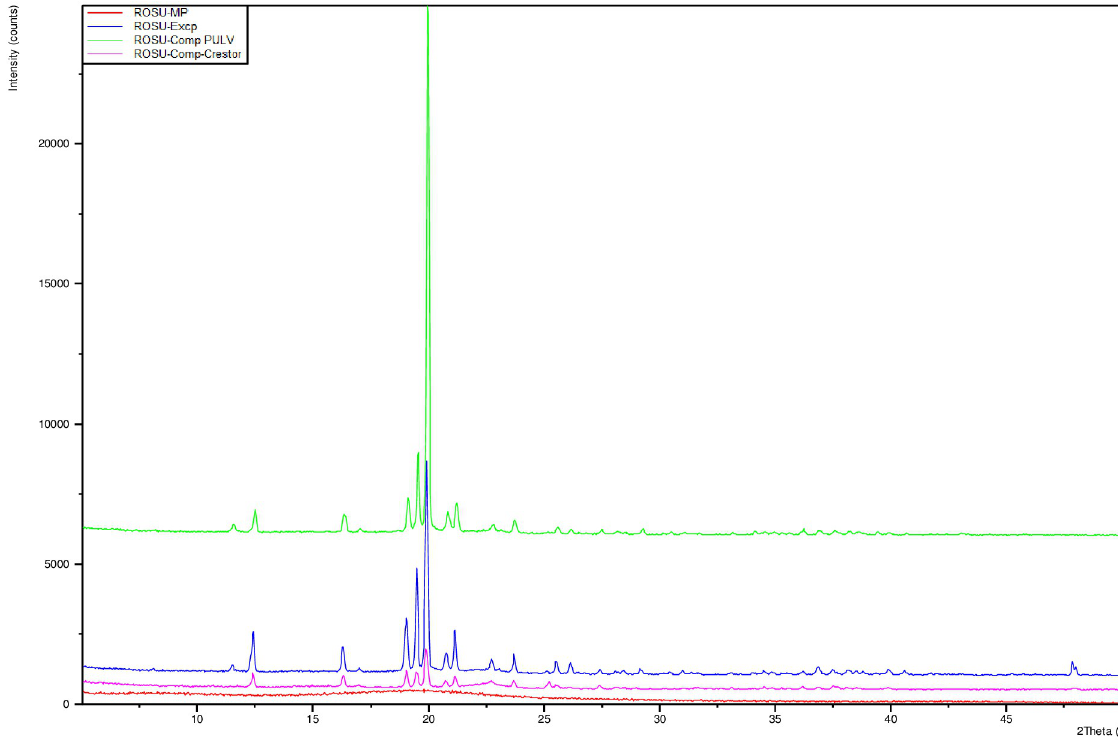
Fig 10. PXRD rosuvastatin calcium. In red is shown the PXRD of pure rosuvastatin calcium, pink the PXRD of marketed tablets, blue the PXRD of mixture drug-excipients, green the PXRD of tablets under study.